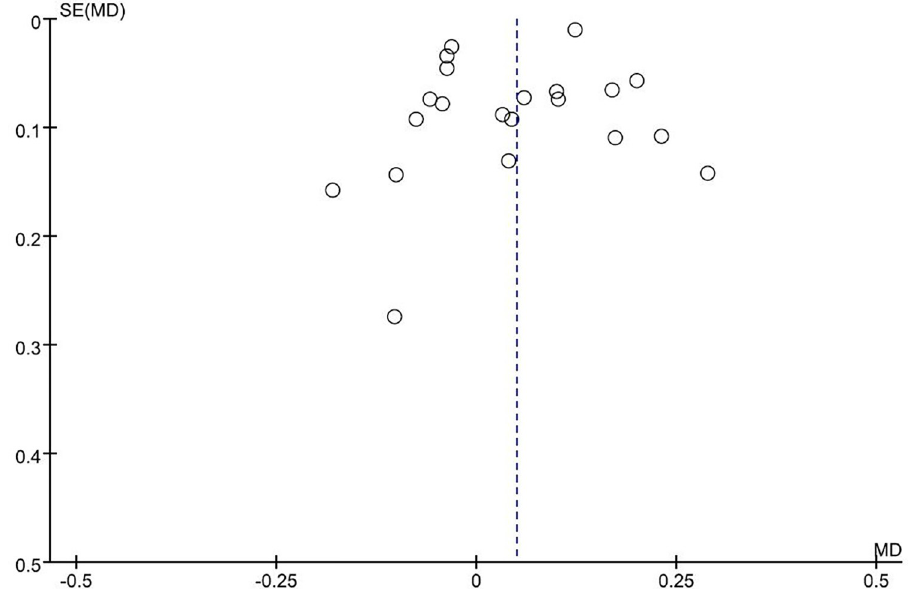
Fig 6. Funnel plot analysis depicting publication